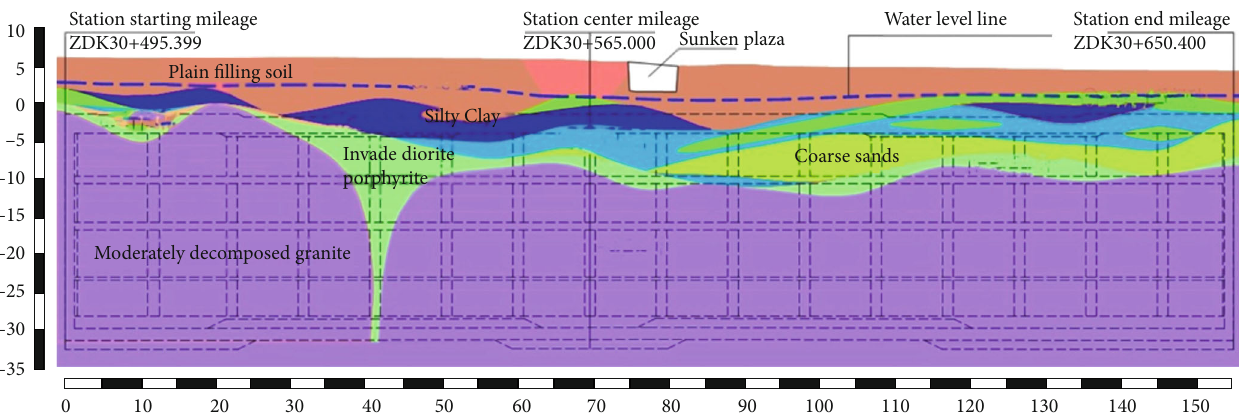
Figure 1: Geological pro fi le along the deep foundation